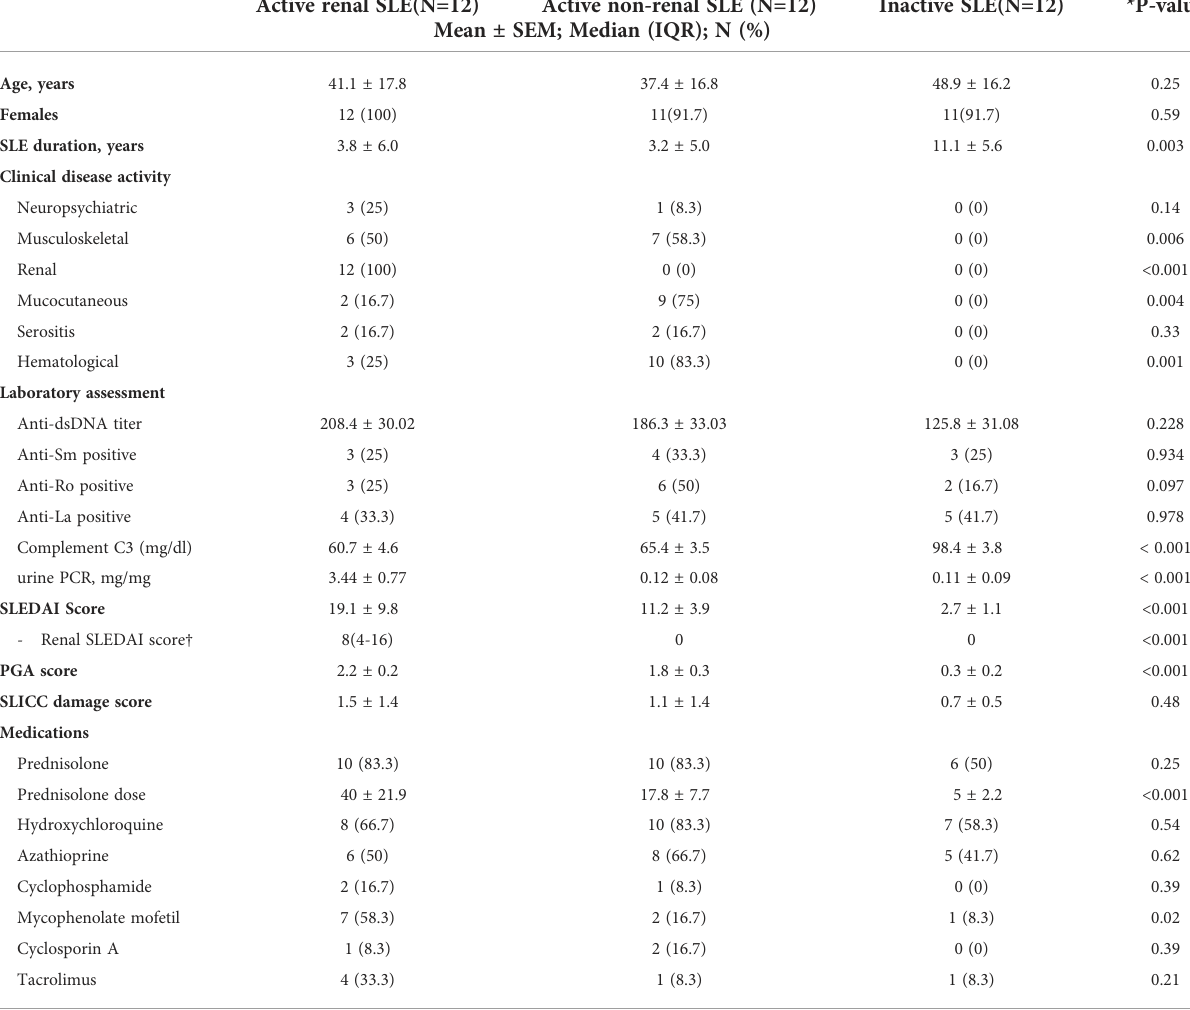
TABLE 1 Demographic and clinical characteristics of SLE